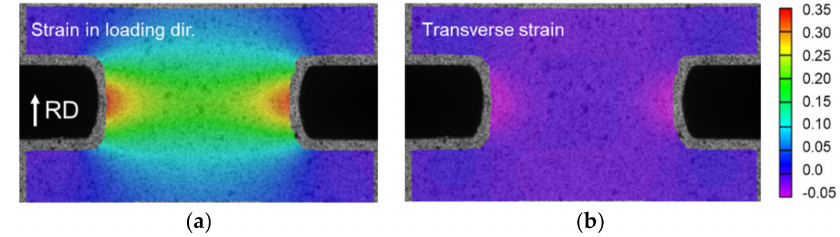
Figure 5. Strain fields measured during plane-strain tension. Strain in ( a ) loading and ( b ) transverse directions, showing zero strain conditions at central part of the